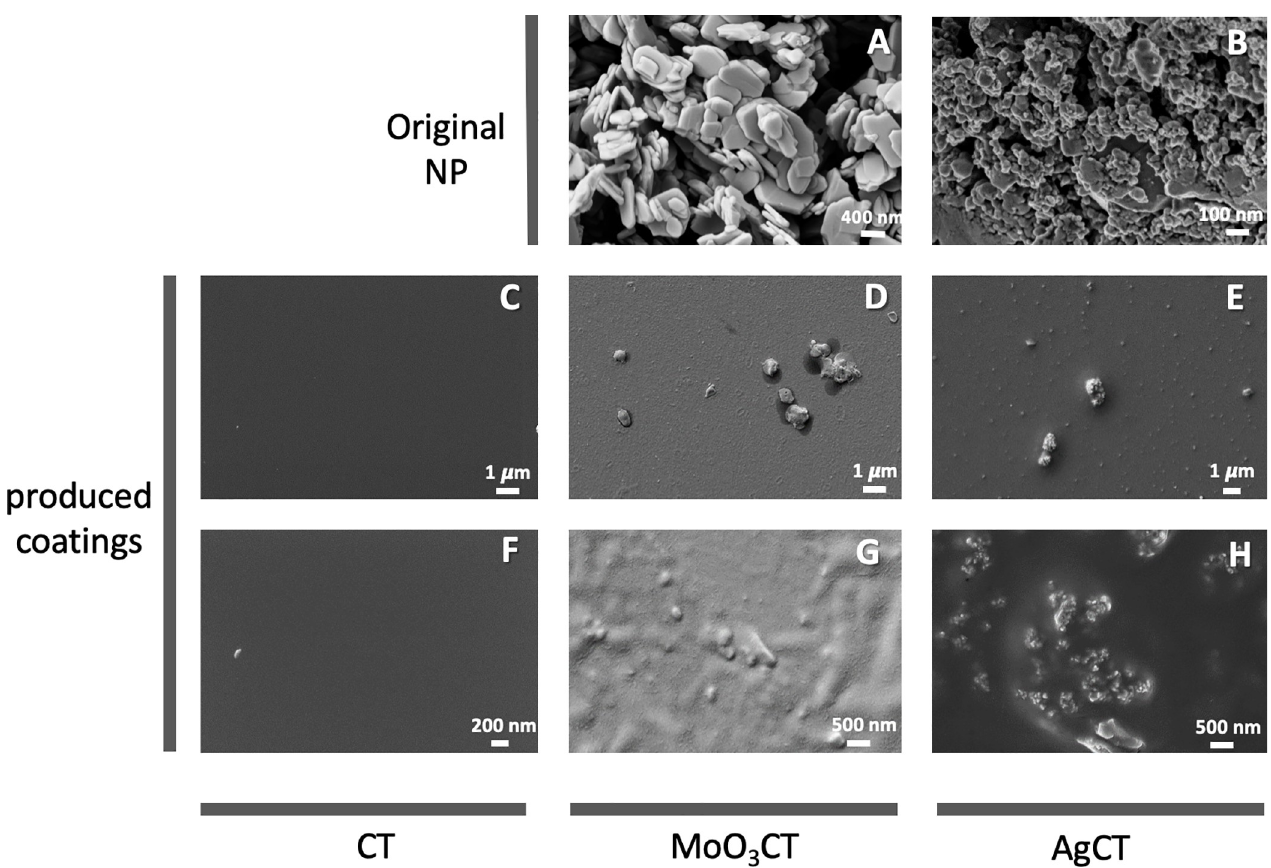
Fig 2. SEM-FIB images of the MoO 3 and Ag NP (A and B, respectively) and the produced coatings; CT (C and F), MoO 3 CT (D and G), and AgCT (E and H).